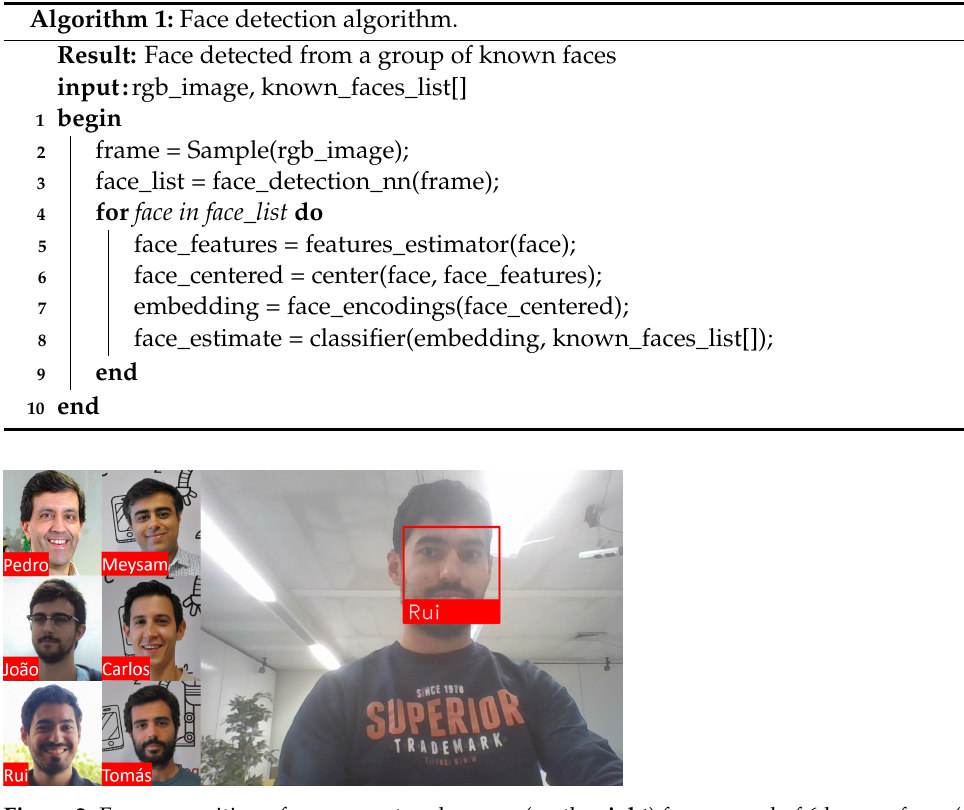
Figure 2. Face recognition of an encountered person (on the right ) from a pool of 6 known faces (on the left